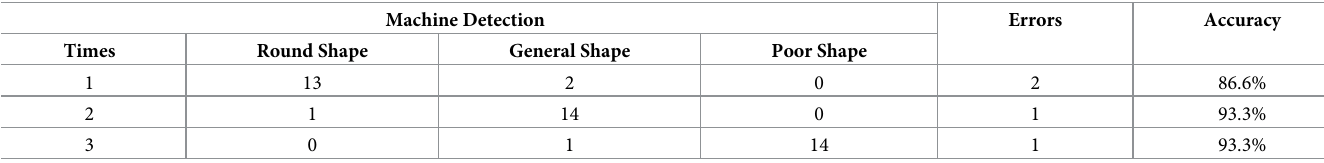
classifier that divides tomato fruits into large, medium and small categories. Table 3. Grading results of tomato shape